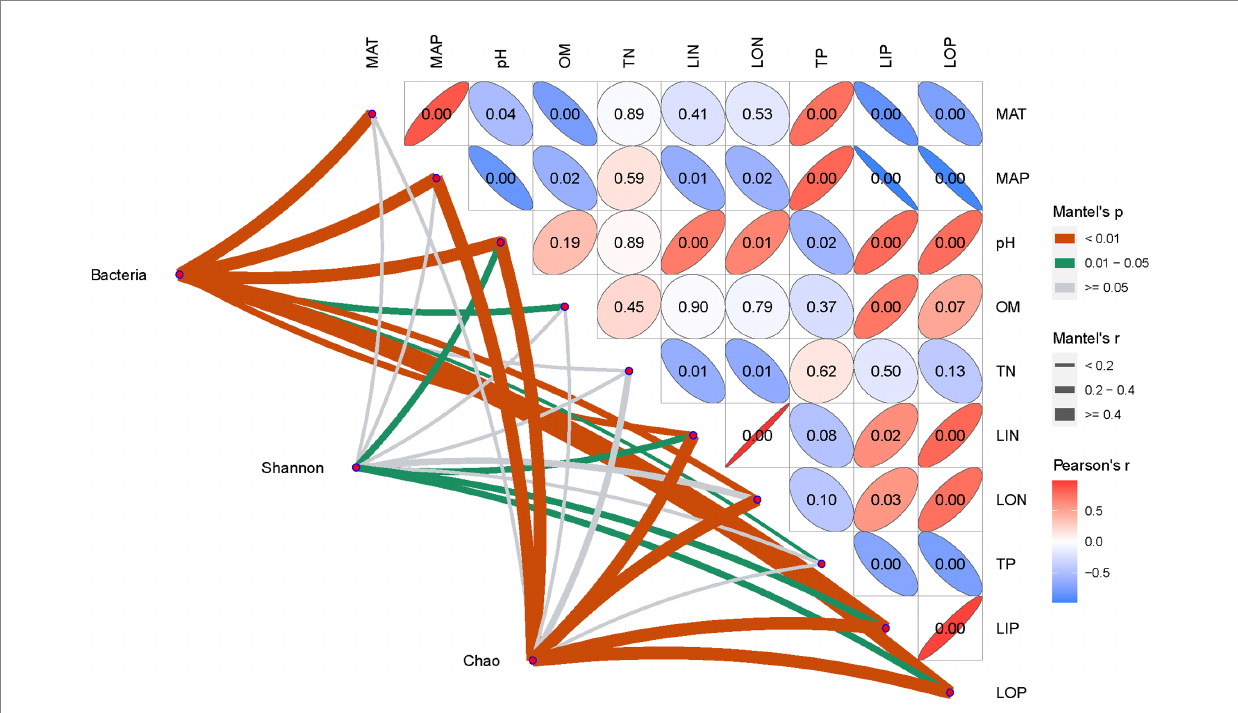
FIGURE 6 Dependent relationship between soil environmental factors and bacterial communities on Mantel test